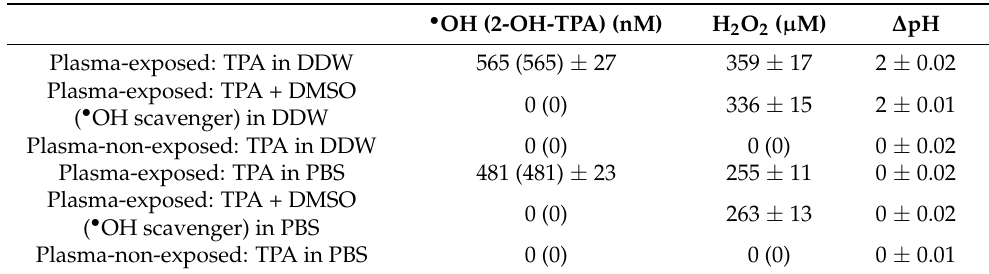
Table 2. Plasma generated • OH and H 2 O 2 in DDW and PBS; values are averages from 5 repeats, with standard deviation around 5%.